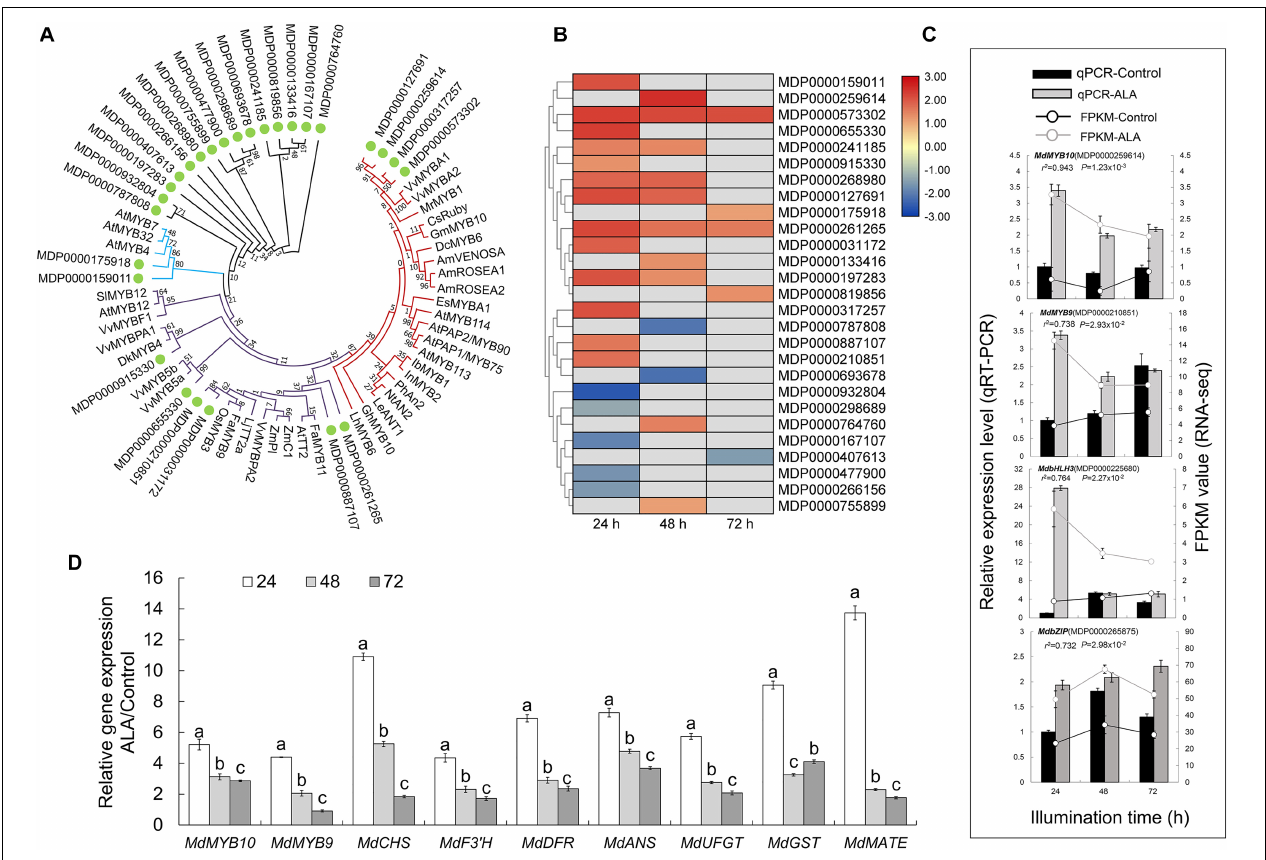
FIGURE 5 | Analysis of differentially expressed MYB transcription factor genes related to putative flavonoid biosynthesis. (A) Phylogenetic tree with 39 phenylpropanoid pathway regulatory MYB TFs and 27 MYB from DEGs. (B) Heat map presenting the expression patterns of differentially expressed of 27 MYB. The depth of color represents the changes of the value of log 2 [fold change (FC)], and red represents up-regulation and blue represents down-regulation. The gray represents genes that did not belong to DEGs at the corresponding time points. (C) Verification of the expression of four differentially expressed transcription factor genes by qRT-PCR analysis. (D) QRT-PCR analysis of the relative expression of MdMYB10 and MdMYBR9 and genes related to anthocyanin biosynthesis and transport in apple flesh calli at 24, 48, and 72 h after ALA treatment. The different letters in each gene represents significant differences ( p <